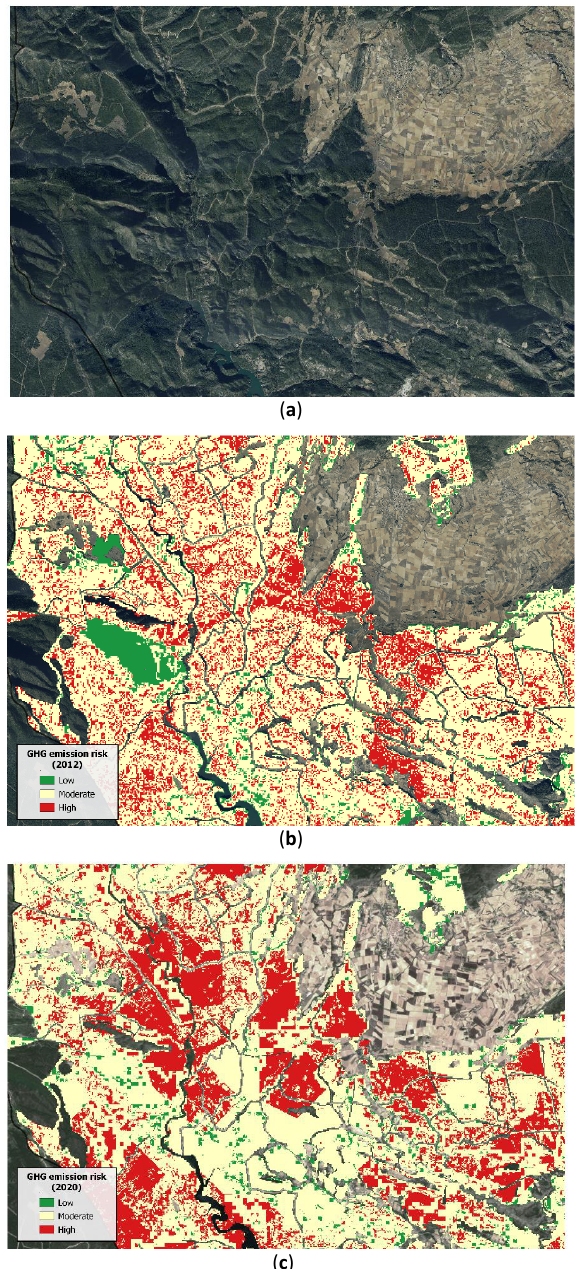
Figure 8. ( a ) Scale-up of La Sazadilla (orthophoto 2010). ( b ) GHG emission risk in 2012. ( c ) GHG emission risk in 2020.